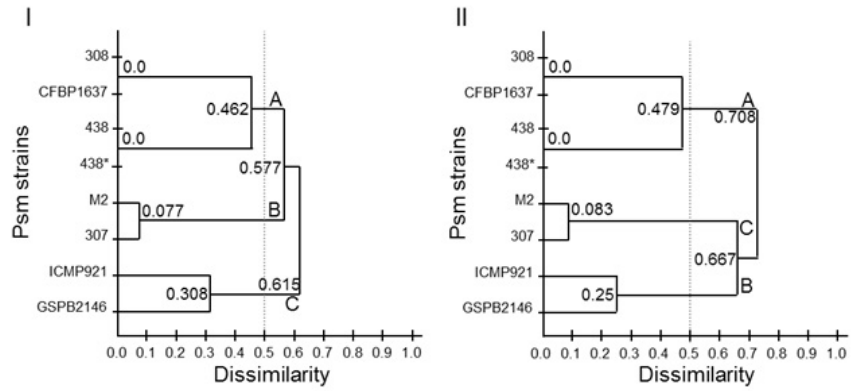
Fig. 2. Genetic dissimilarity for 8 Psm strains, clustering with UPGMA. I obtained with Pme I, and II obtained with Pac